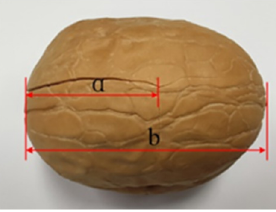
Figure 5. Crack length measurement in the longitudinal direction, a is the crack length, b is the longitudinal diameter. longitudinal diameter.